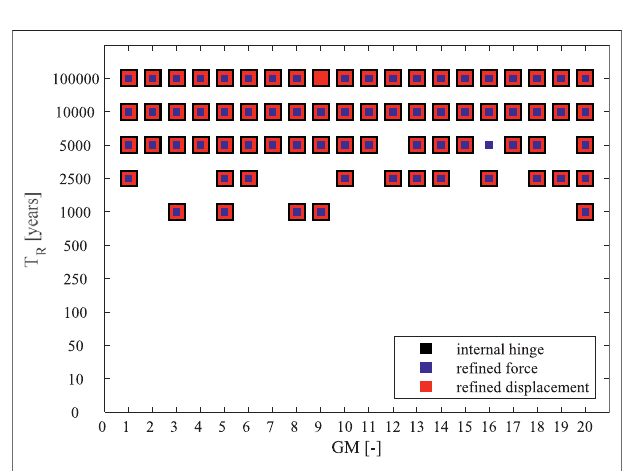
FIGURE 11 | Collapse cases recorded by the multistripe